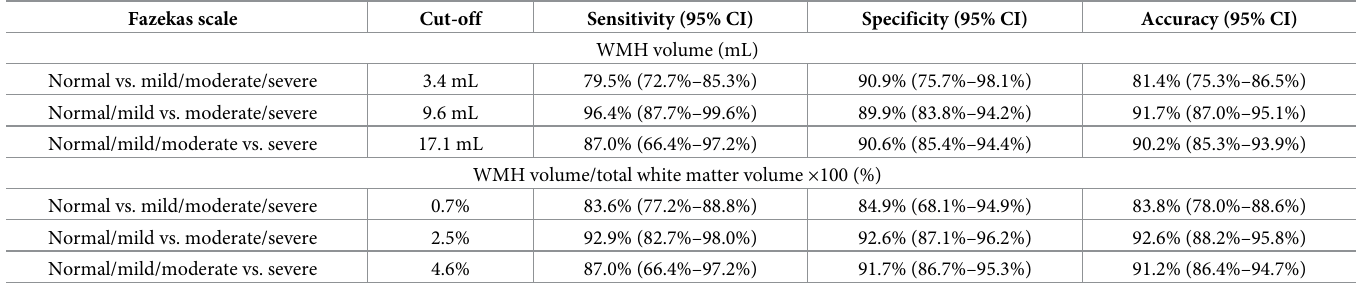
Table 2. Diagnostic performance of WMH volume for differentiating Fazekas scale with its cut-off values. Fazekas